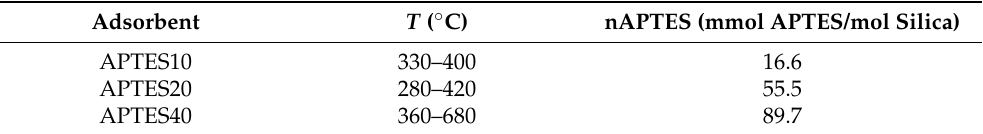
Table 2. Content of APTES in the adsorbent particles.